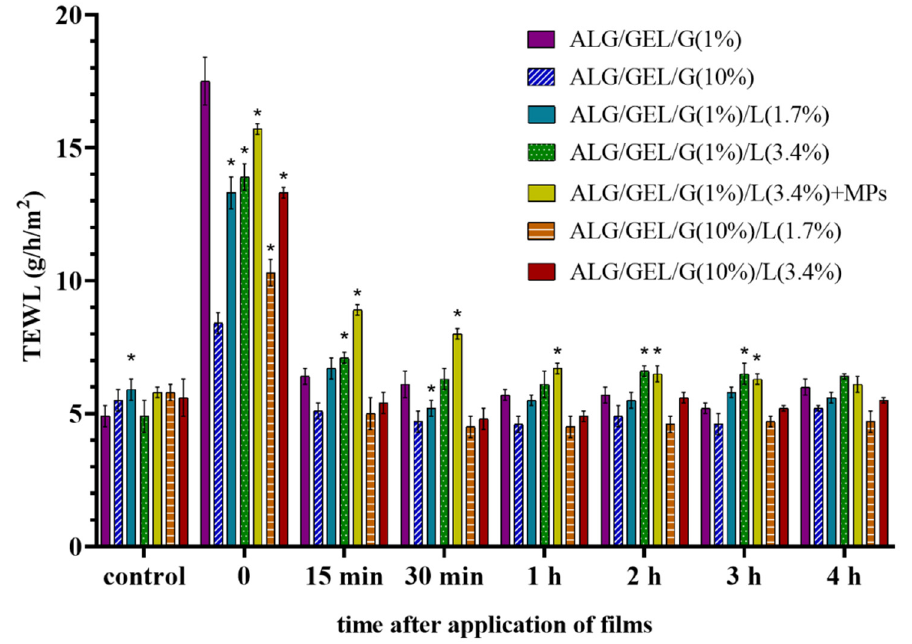
Figure 10. Skin barrier quality (transepidermal water loss—TEWL) after application of films based on sodium alginate and gelatin with different amounts of glycerol and lipids, as well as the sample with incorporated PLA microparticles. The control measurements were performed before the application of materials to the skin, whereas time = 0 refers to the tests taken immediately after removal of the films that had been applied to the skin for 10 min. Significant differences compared to the control samples: ALG/GEL/G (1%) and ALG/GEL/G (10%) for each time were marked on the graphs with (*).